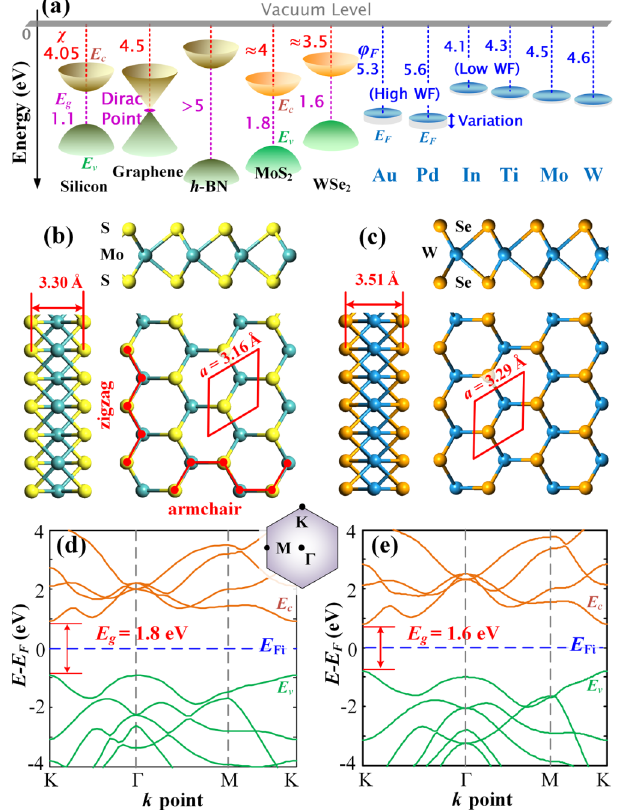
FIG. 2. (a) Band diagrams of silicon, some 2D materials, and selected contact metals. Graphene [1,2] has a zero-band-gap electronic dispersion at so-called Dirac points, while h -BN has a large E ( > 5 eV) and can be used as an extremely thin dielectric g layer [3]. E , E , and E represent conduction band edge, valence c v g band edge, and band gap, respectively. χ and ϕ represent F electron affinities and metal work functions (WFs), respectively. (b),(c) Three views of lattice structures of (b) MoS 2 and (c) WSe 2 . Red rhombuses represent primitive unit cells and a is the lattice constant. Chirality is shown in (b) by armchair edge and zigzag edge. Lattice structures are relaxed using DFT with 8 × 8 × 1 k points sampled in the Brillouin zone (BZ). (d),(e) Energy dispersions of (d) MoS 2 and (e) WSe 2 . E denotes the intrinsic Fi Fermi level. Inset in (d) shows the first BZ of mTMDs containing the M , K , and Γ points.